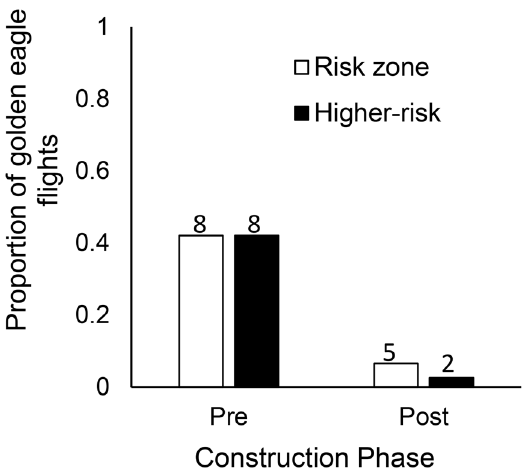
Figure 6. Proportion of risk zone and higher-risk crosses under headwinds. Proportion of golden eagle ridge-top crosses within risk zone ( # 150 m above ground) and of higher-risk (within risk zone at winds above turbine cut-in speed 6.8 km/h) under headwind conditions during pre- and post-construction. Values above bars represent sample